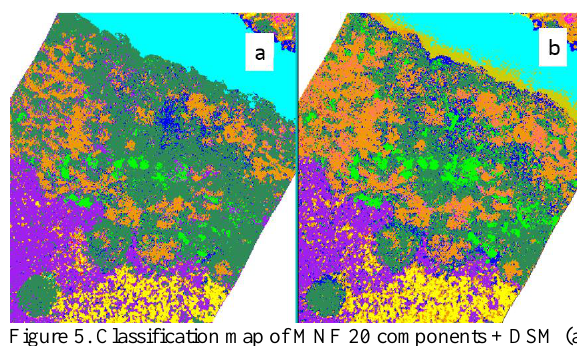
Figure 5. Classification map of MNF 20 components + DSM (a: SVM classifier; b: MLC)